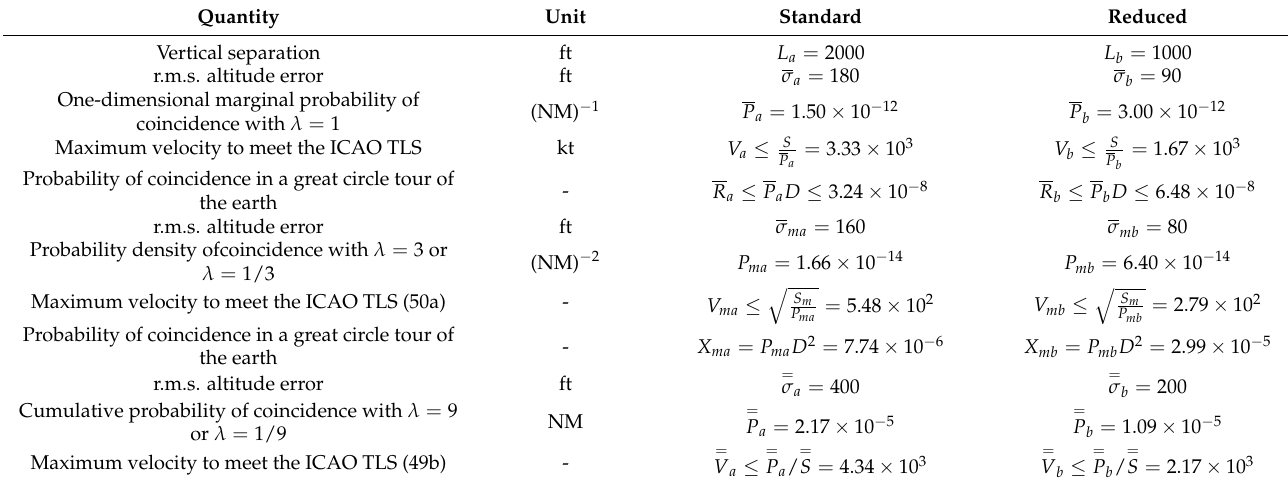
Table 4. Comparison of the International Civil Aviation Organization (ICAO) Target Level of Safety (TLS) applied to: (top) the one-dimensional marginal probability of coincidence along the flight path (25b); (middle) the maximum of the joint probability of coincidence (11); (bottom) the three-dimensional cumulative probability of coincidence over all space (13). In each case is considered; (left) the standard vertical separation L a = 2000 ft; (right) the reduced vertical separation L b = 1000 ft. For each of the six combinations of identical aircraft is indicated: (i) the assumed r.m.s. altitude position error; (ii) the corresponding probability of coincidence; (iii) the maximum speed that meets the ICAO TLS in the original or modified form; (iv) the probability of coincidence for a great circle tour of the